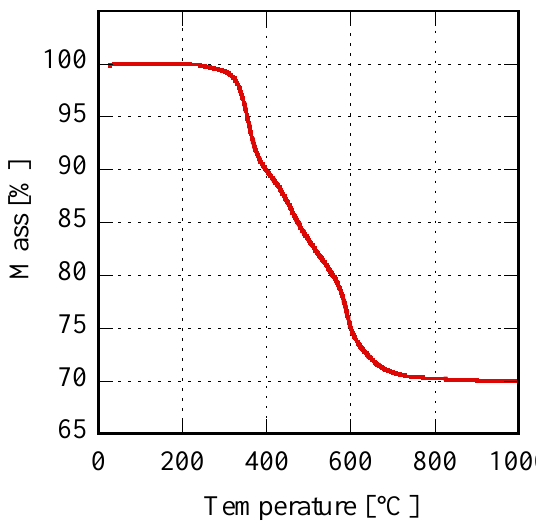
Figure 5. Thermogravimetric plot of sample Er8h.